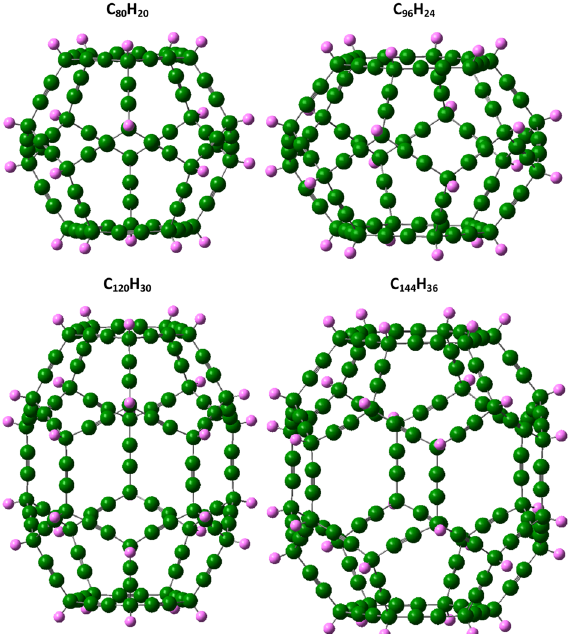
Figure 1. The fullerynes, C 80 H 20 , C 96 H 24 , C 120 H 30 , and C 144 H 36 structures, were obtained, respectively, for